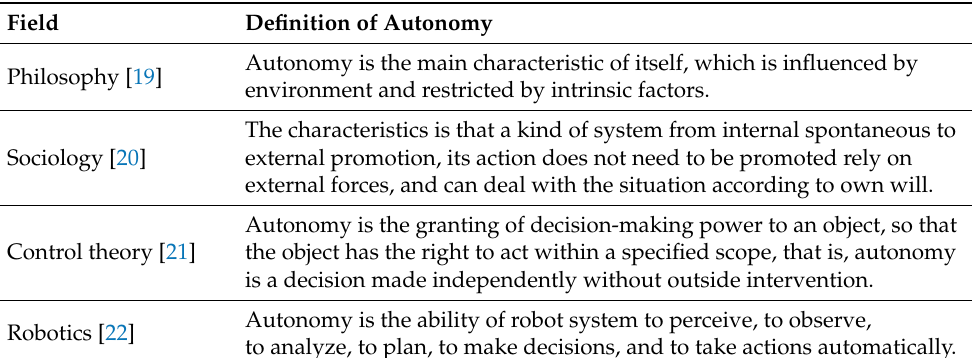
Table 1. Definitions of autonomy in different